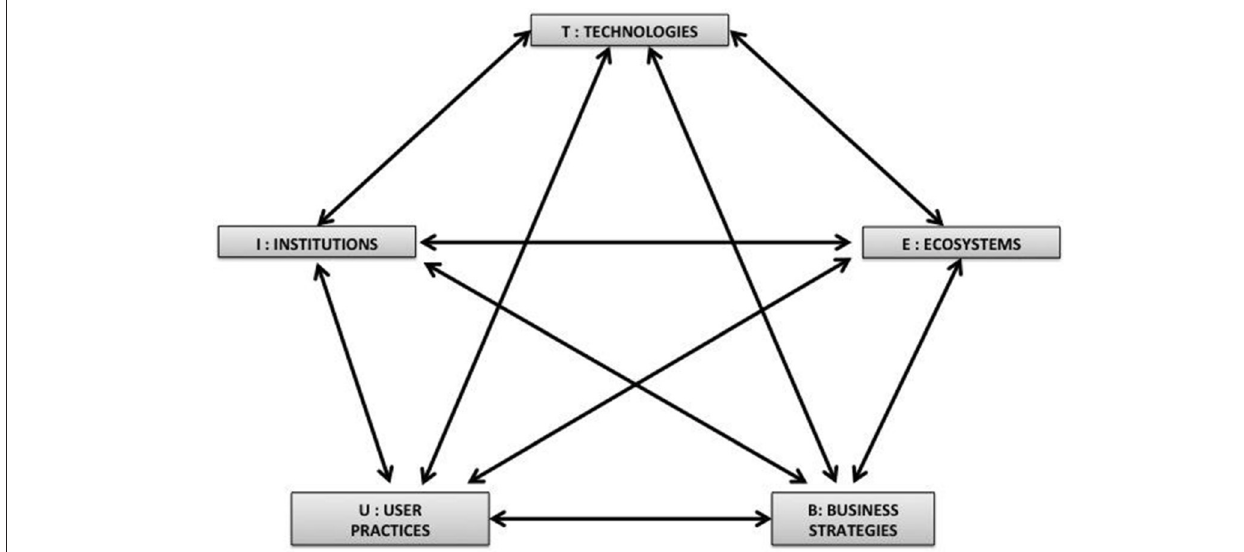
FIGURE 1 | Coevolutionary framework (Foxon, 2011).